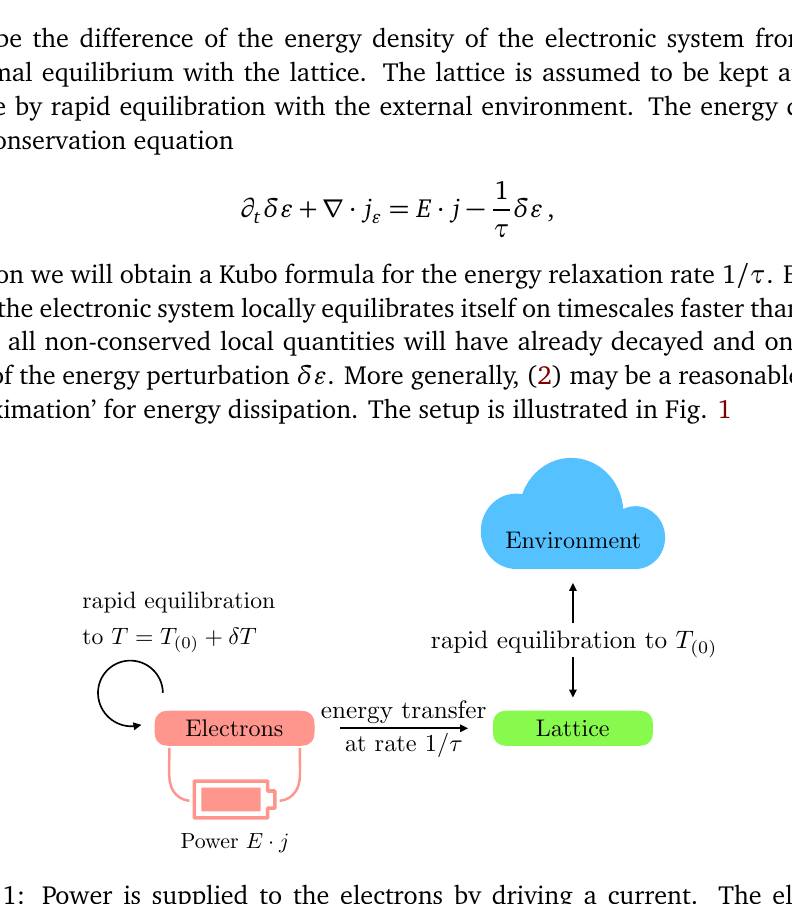
Figure 1: Power is supplied to the electrons by driving a current. The electrons rapidly thermalize to a temperature δ T above the temperature of the thermalized lattice and environment. Heat is consequently transferred to the lattice, at a rate 1 /τ